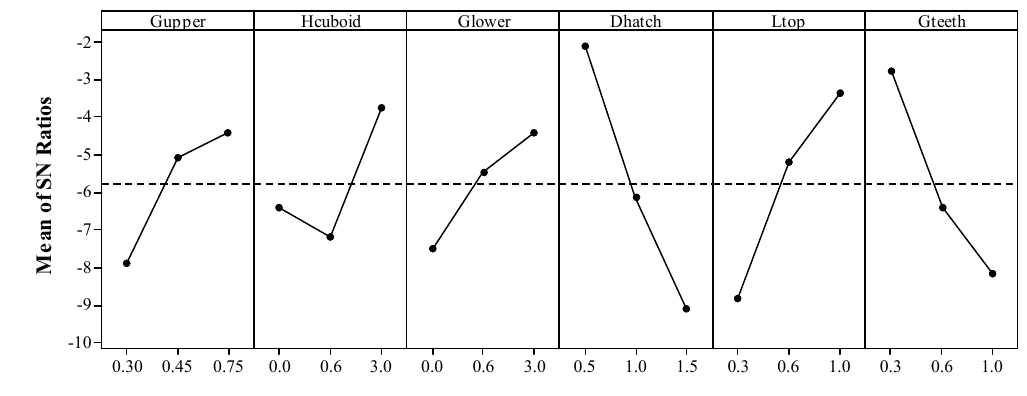
Figure 8. Main effects plot for S / N W ratio.